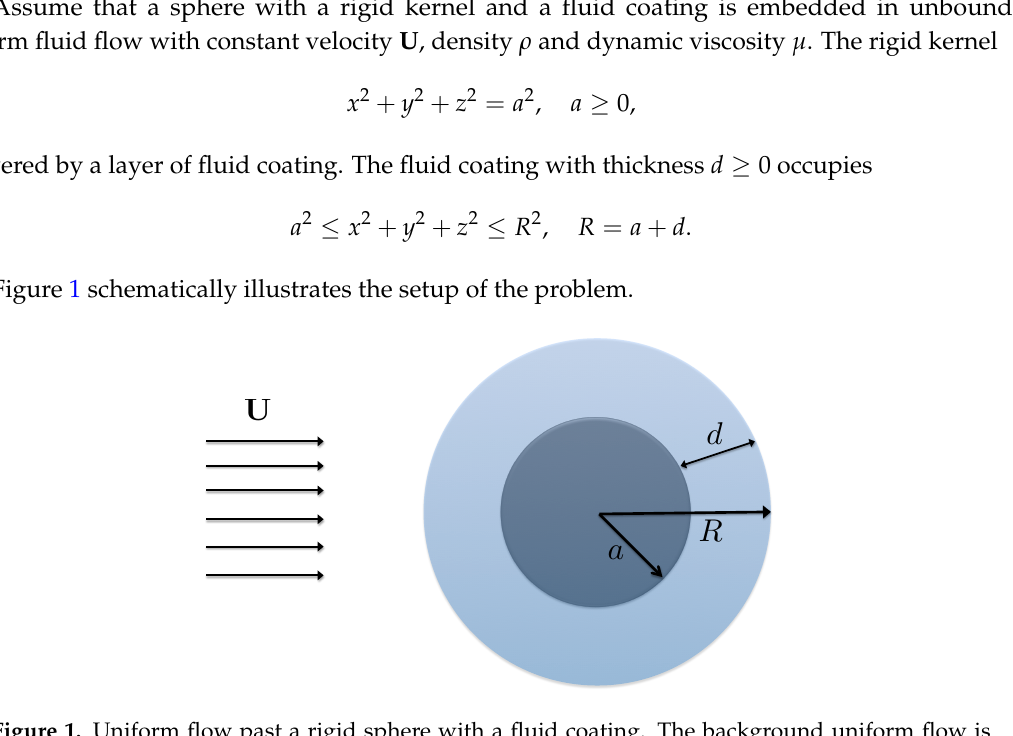
Figure 1. Uniform flow past a rigid sphere with a fluid coating. The background uniform flow is U = U e z . The dark colored region indicates the rigid spherical kernel with radius a . The light colored region shows the fluid coating with thickness d . In total, the radius of the obstacle is R = a + d